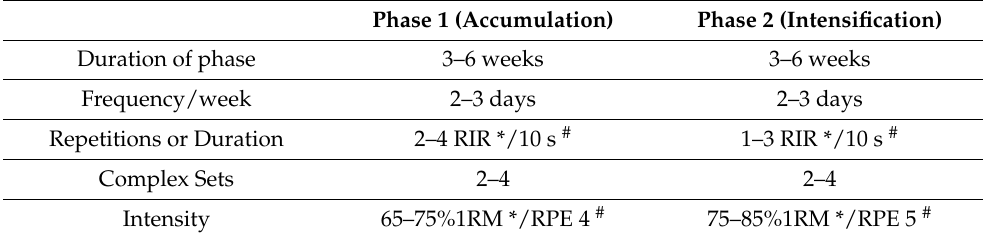
Table 2. Example of periodisation model for complex training adapted for the